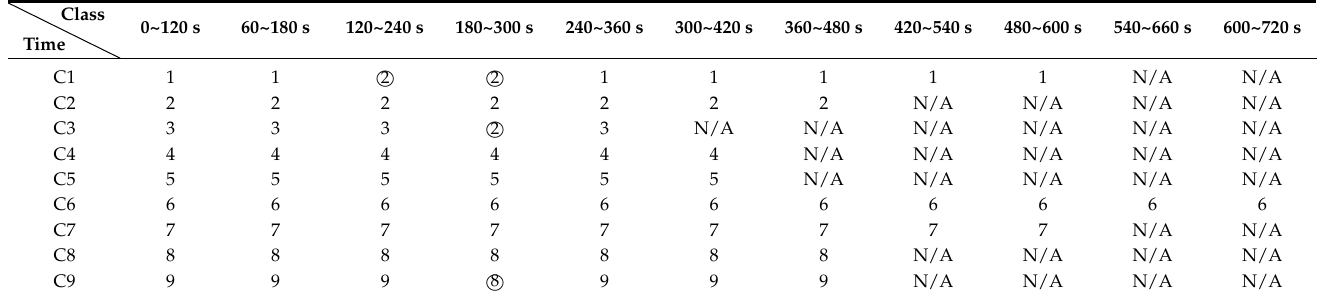
Table 6. Classification results of the network.